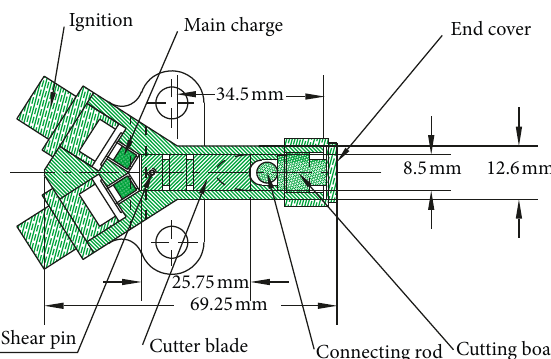
Figure 1: Schematic of the pyrotechnic cutter.